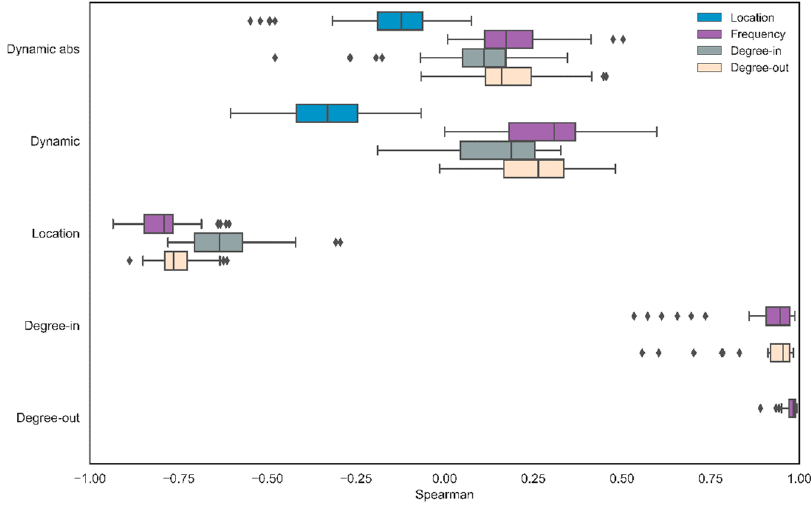
Figure 8. This graph presents the Spearman correlations between the object-based dynamic and log- frequency, average location, degree-in, and degree-out. log-frequency, average location, degree-in, and